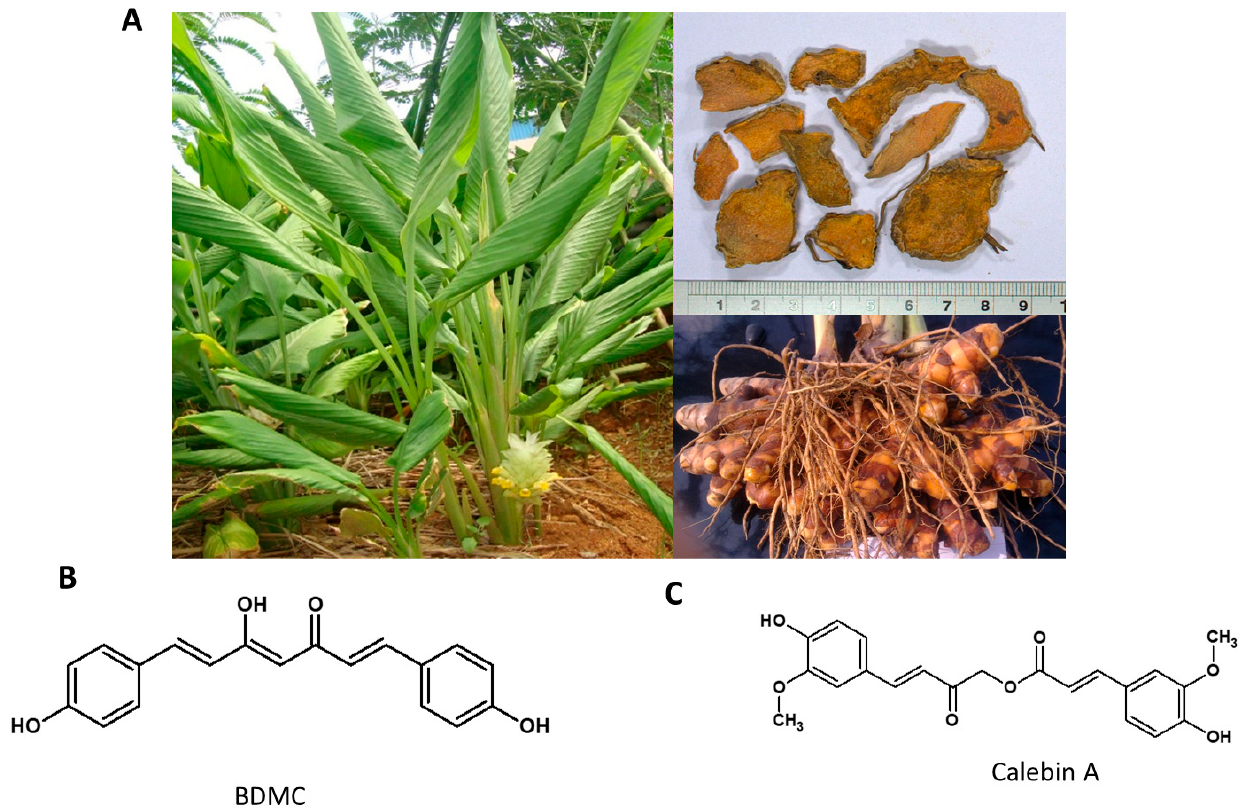
Figure 6. Curcuma longa . ( A ) Habit of the Plant; Bunch of fingers; and dried rhizome slice ( B ) Bisdemethoxycurcumin (BDMC), ( C ) Calebin A.